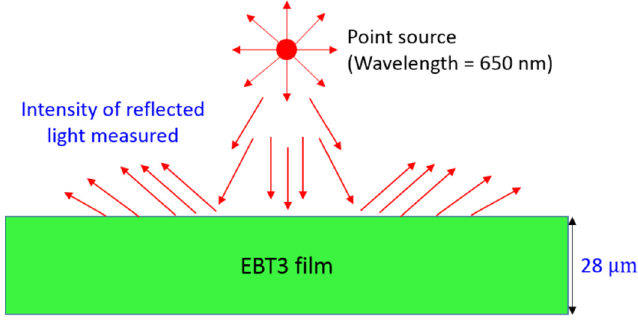
Figure 4. Flowchart summarizing approach to determine Net ROD .